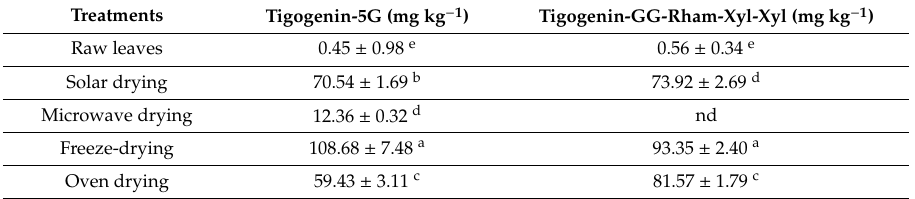
Table 9. Effect of different drying treatments on saponins (Tigogenin-5G and Tigogenin-GG-Rham-Xyl-Xyl.